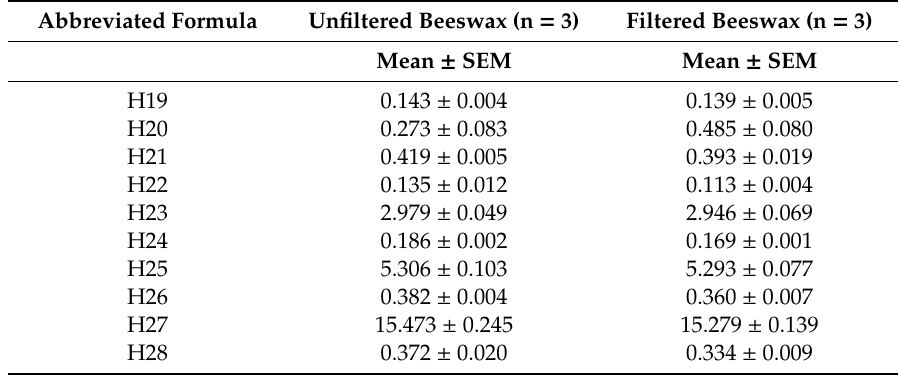
Table 2. Aliphatic hydrocarbons content (%) in beeswax before and after the filtration process. Abbreviated